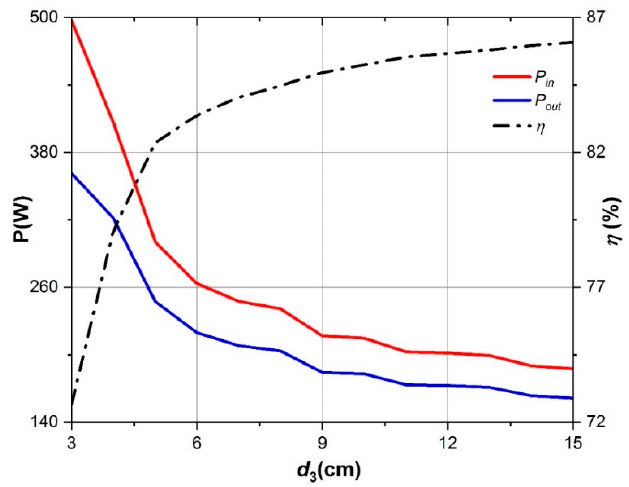
Figure 13. Power transfer and efficiency versus the distance d 3 .